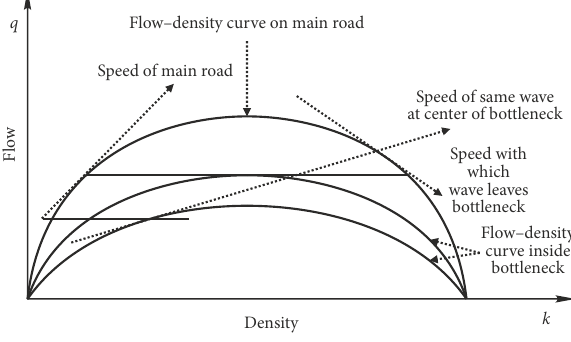
Figure 7. Changes in flow–density ( q – k )